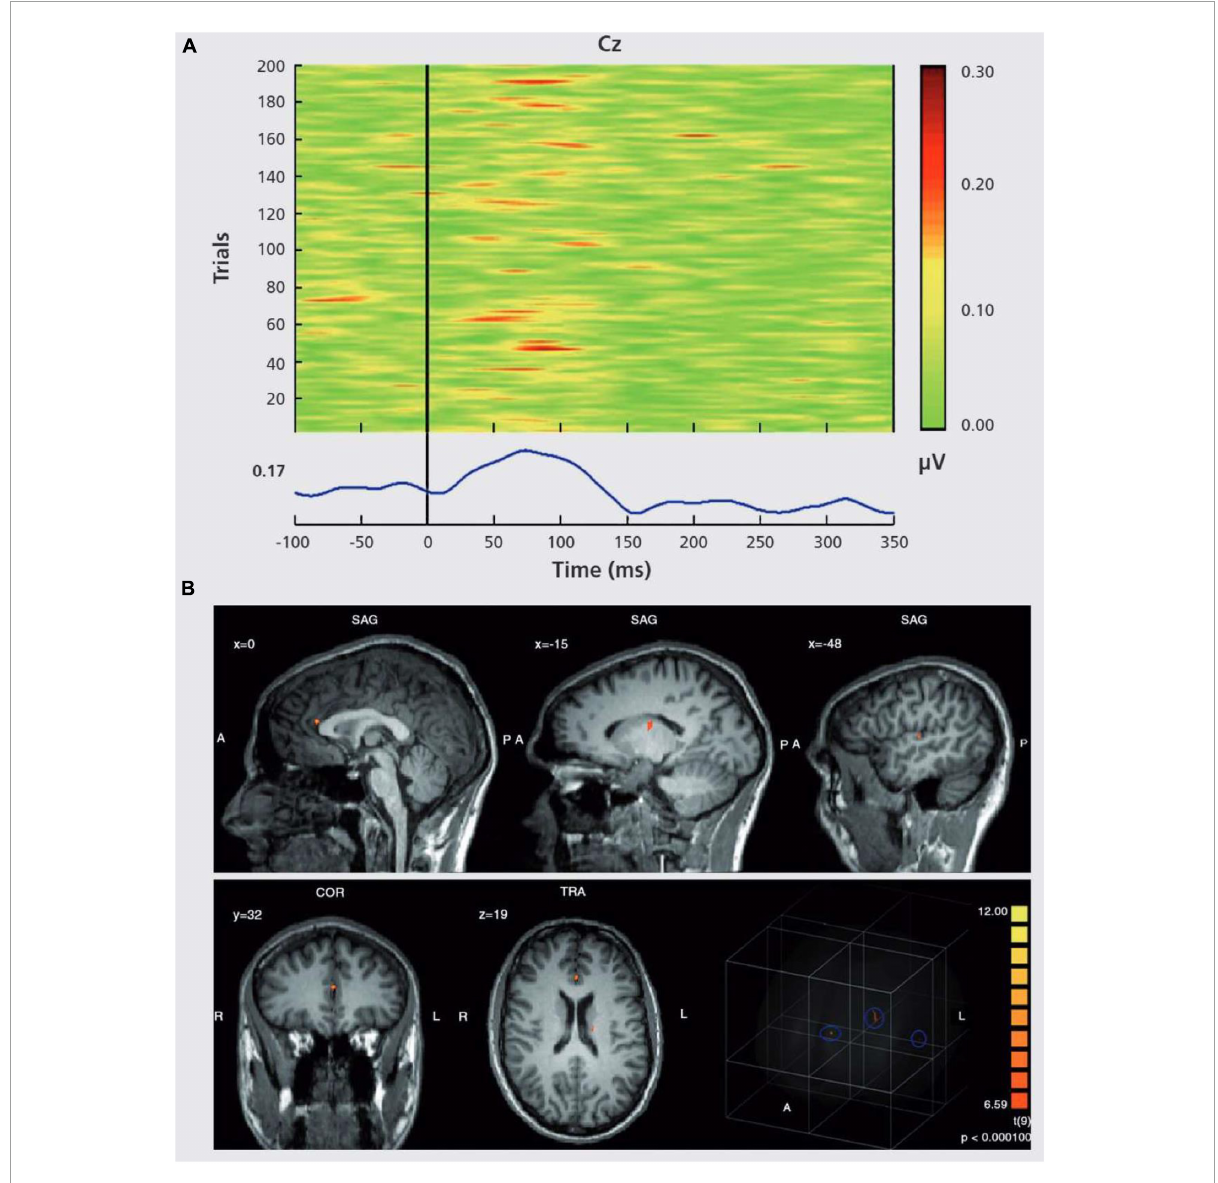
FIGURE10 “EEG-informed fMRI analysis in an auditory choice reaction task.” (A) EEG single-trial data of a typical data set at electrode Cz. In many trials, a GBR between 30 and 100 ms post-stimulus is present. However, the amplitudes of the GBR are variable over time. This variability can be used for specific predictions of the related BOLD signal. In the lower part of the figure, the corresponding averaged GBR is shown. (B) GBR-specific BOLD activation based on the single-trial coupling of GBR amplitude variation and the corresponding BOLD activation. Activations can be seen in the left auditory cortex (gyrus temporalis superior, Brodmann area 41/22, highest t -value 8.3), the thalamus (highest t -value 7.6) and the anterior cingulate cortex (Brodmann area 24, highest t -value 10.1). In the lower right corner, a glass brain view is provided, demonstrating a 3D view of the three abovementioned clusters. Activations are shown at P. (Mulert et al.,